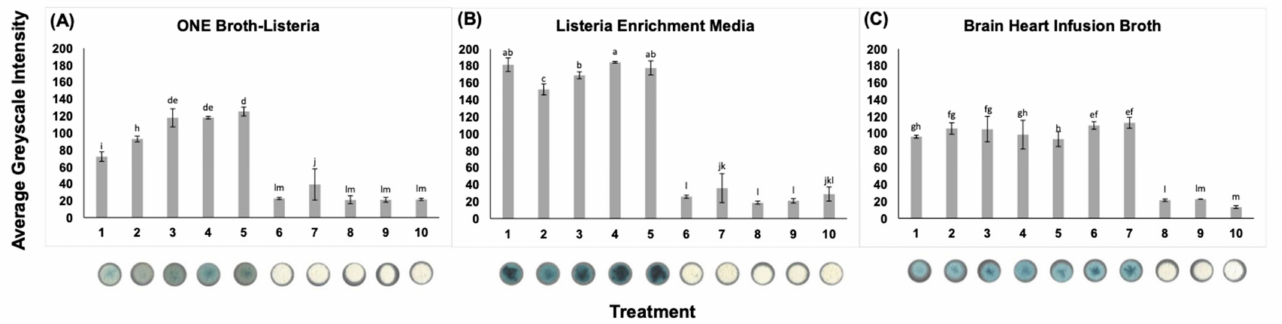
Figure 2. Evaluation of microbiological media for the development of a test specific for the detection of Listeria spp. Target L. monocytogenes was detected using every broth tested. Non-target E. coli and B. pumilus , the latter of which produces the target enzyme β -glucosidase, were both inhibited by the selective enrichment broths ONE Broth-Listeria and Listeria Enrichment Media. The average greyscale intensity was determined using ImageJ. Bars show standard deviations of three means. Means with different letters are significantly different. Digitized colorimetric images. Representative wells are depicted. ( A ) ONE Broth-Listeria, ( B ) Listeria Enrichment Media, ( C ) Brain Heart Infusion broth. From left to right on the x-axis are the following treatments: (1) L. monocytogenes 1 CFU/mL,